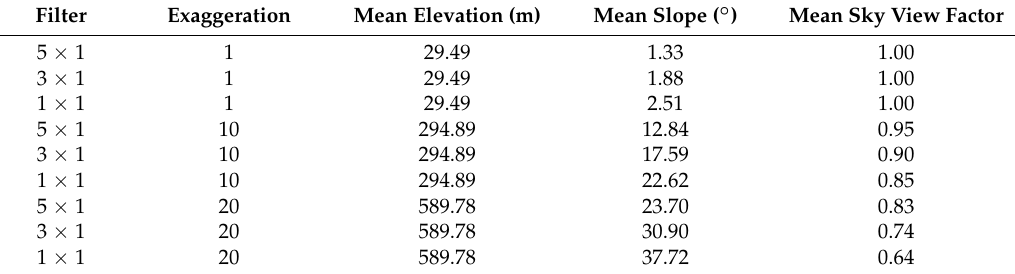
Table 1. Basic parameters for nine simulated DEMs.